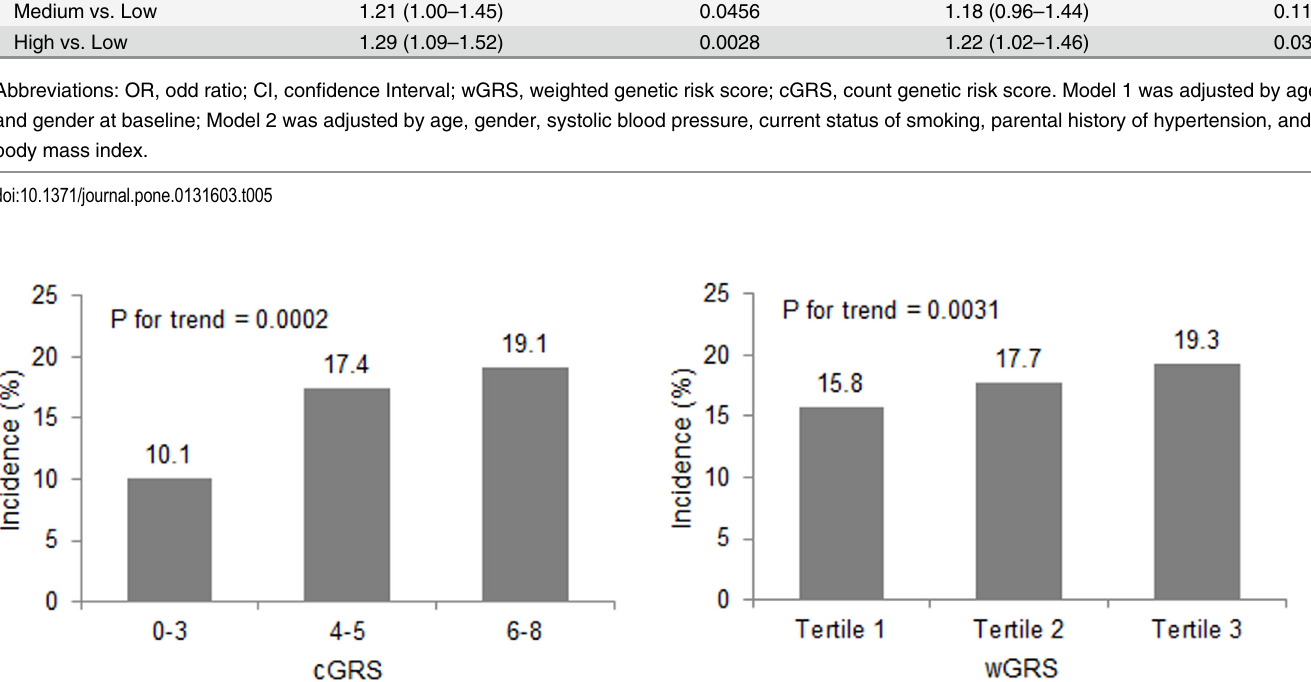
Fig 2. Cumulative incidence of hypertension according to cGRS and wGRS. Abbreviations: cGRS, unweighted genetic risk score; wGRS, weighted genetic risk score. P for trend means p-value for Cochran-Armitage linear trend test.